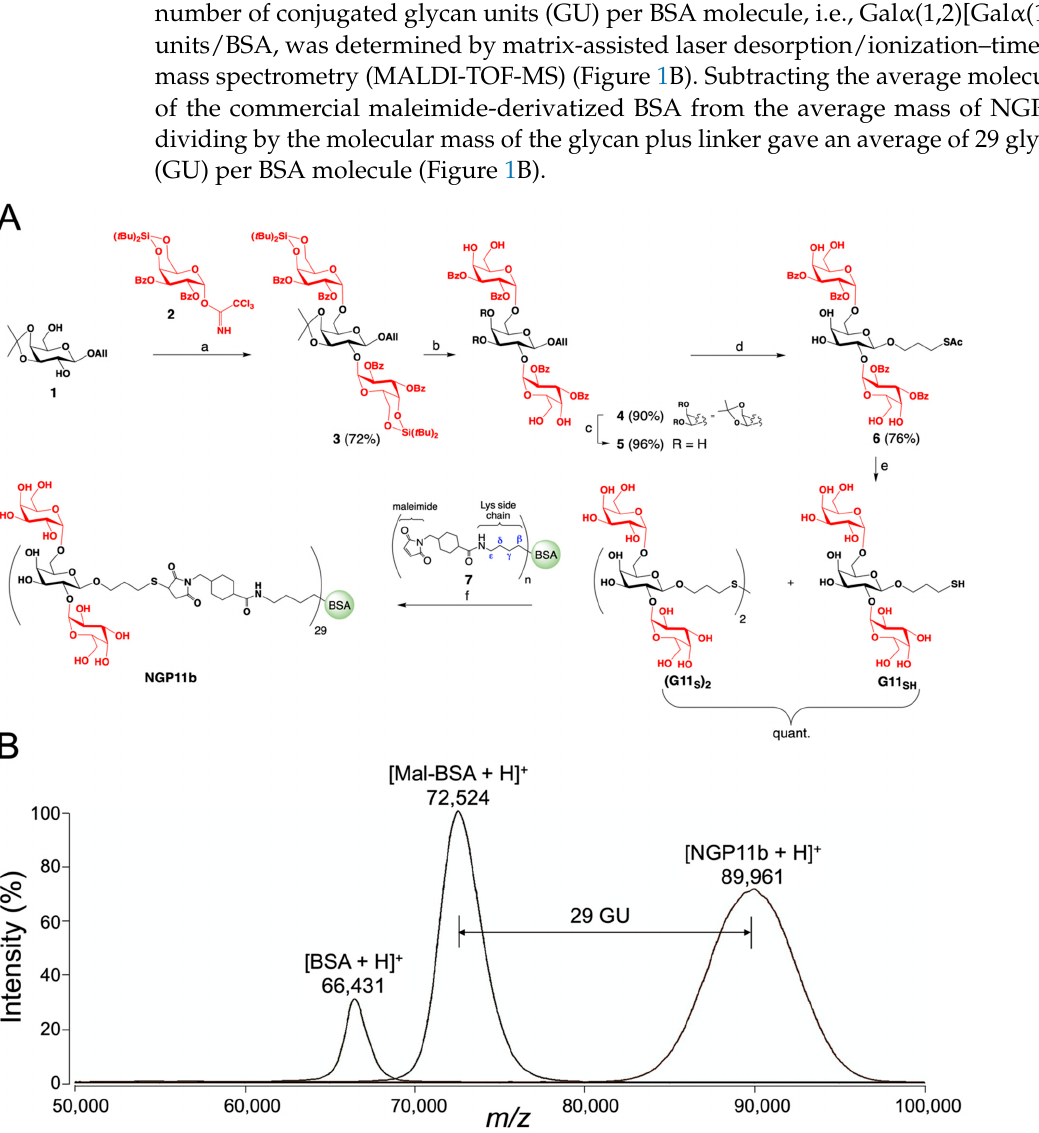
Figure 1. ( A ) Synthesis of the trisaccharide 3-thiopropyl α -D-galactosyl-(1,2)-[ α -D-galactosyl-(1,6)]- β -D-galactoside ( G11 SH ) and its conjugation with maleimide-derivatized BSA to afford NGP11b. (a) TMSOTf, DCM; (b) HF-pyr, THF; (c) DCM, TFA, H 2 O; (d) AcSH, AIBN, THF, UV light (350 nm); (e) NaOMe, MeOH; (f) TCEP-HCl, pH 7.2. ( B ) Overlaid MALDI-TOF mass spectra of singly charged molecular ions of BSA ([BSA + H] + ), maleimide-BSA ([Mal-BSA + H] + ), and NGP11b ([NGP11b + H] + ) are indicated. GU, glycan unit; m/z , mass to charge ratio.